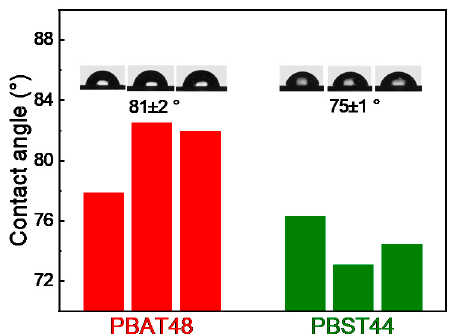
Figure 8. Static hydrophilic contact angle of PBAT48 and